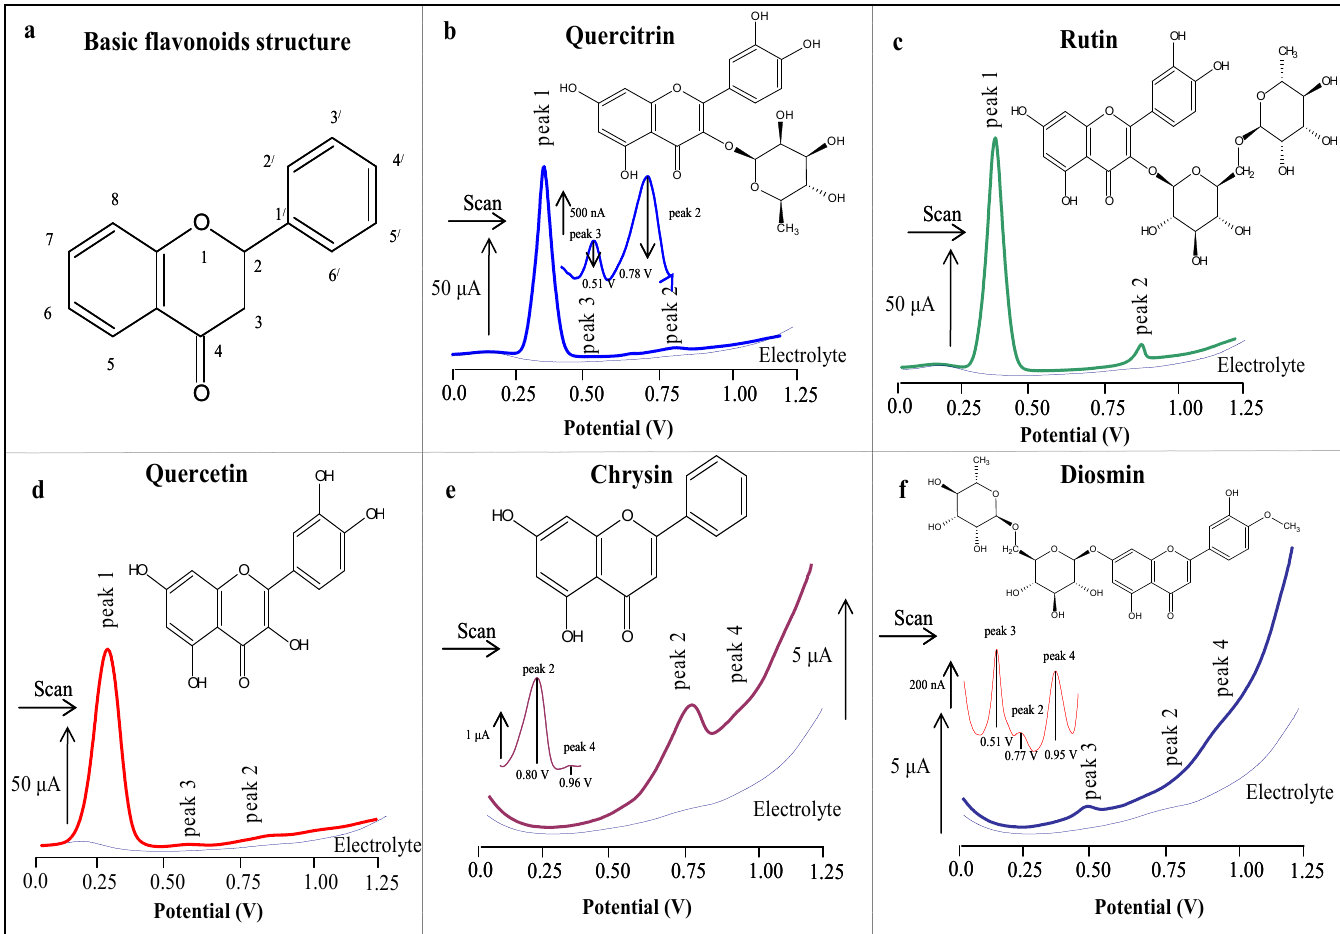
Figure 2. Flavonoid structure made of two benzene rings linked by heterocyclic pyrane ( a ). Square– wave voltammograms of the flavonoids (10 μ M) and their structures – quercitrin ( b ), rutin ( c ), quercetin ( d ), chrysin ( e ) and 100 μ M of diosmin ( f ). Square wave voltammetric parameters were